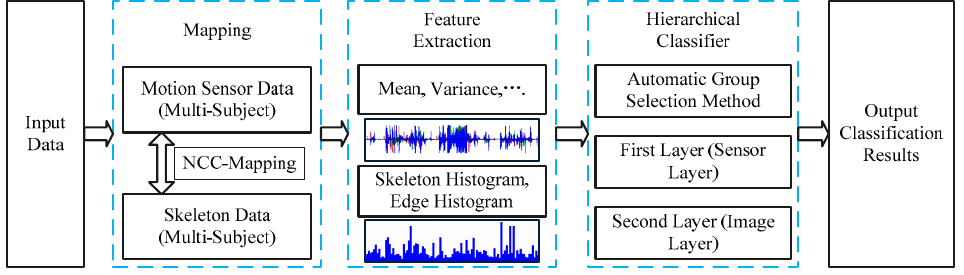
Figure 2. Overview of the proposed method.